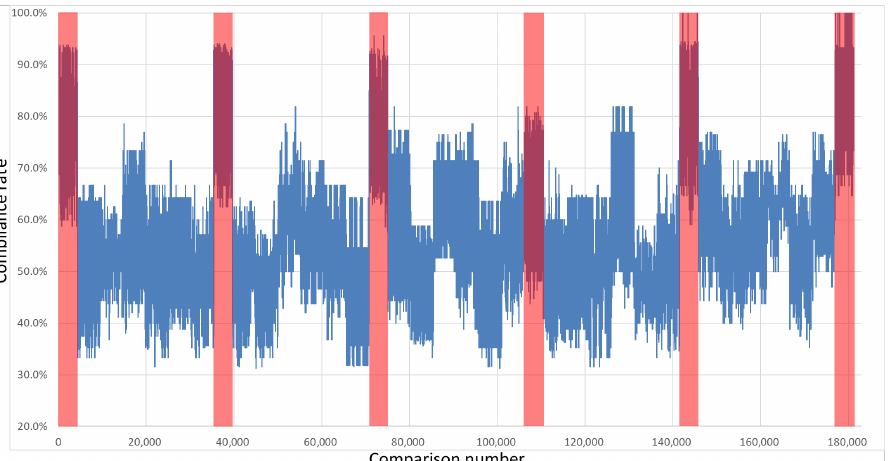
Figure 8. Results of the comparison of each key pair for all boards in a set—Xilinx Spartan 6 x 4 + x 3 +